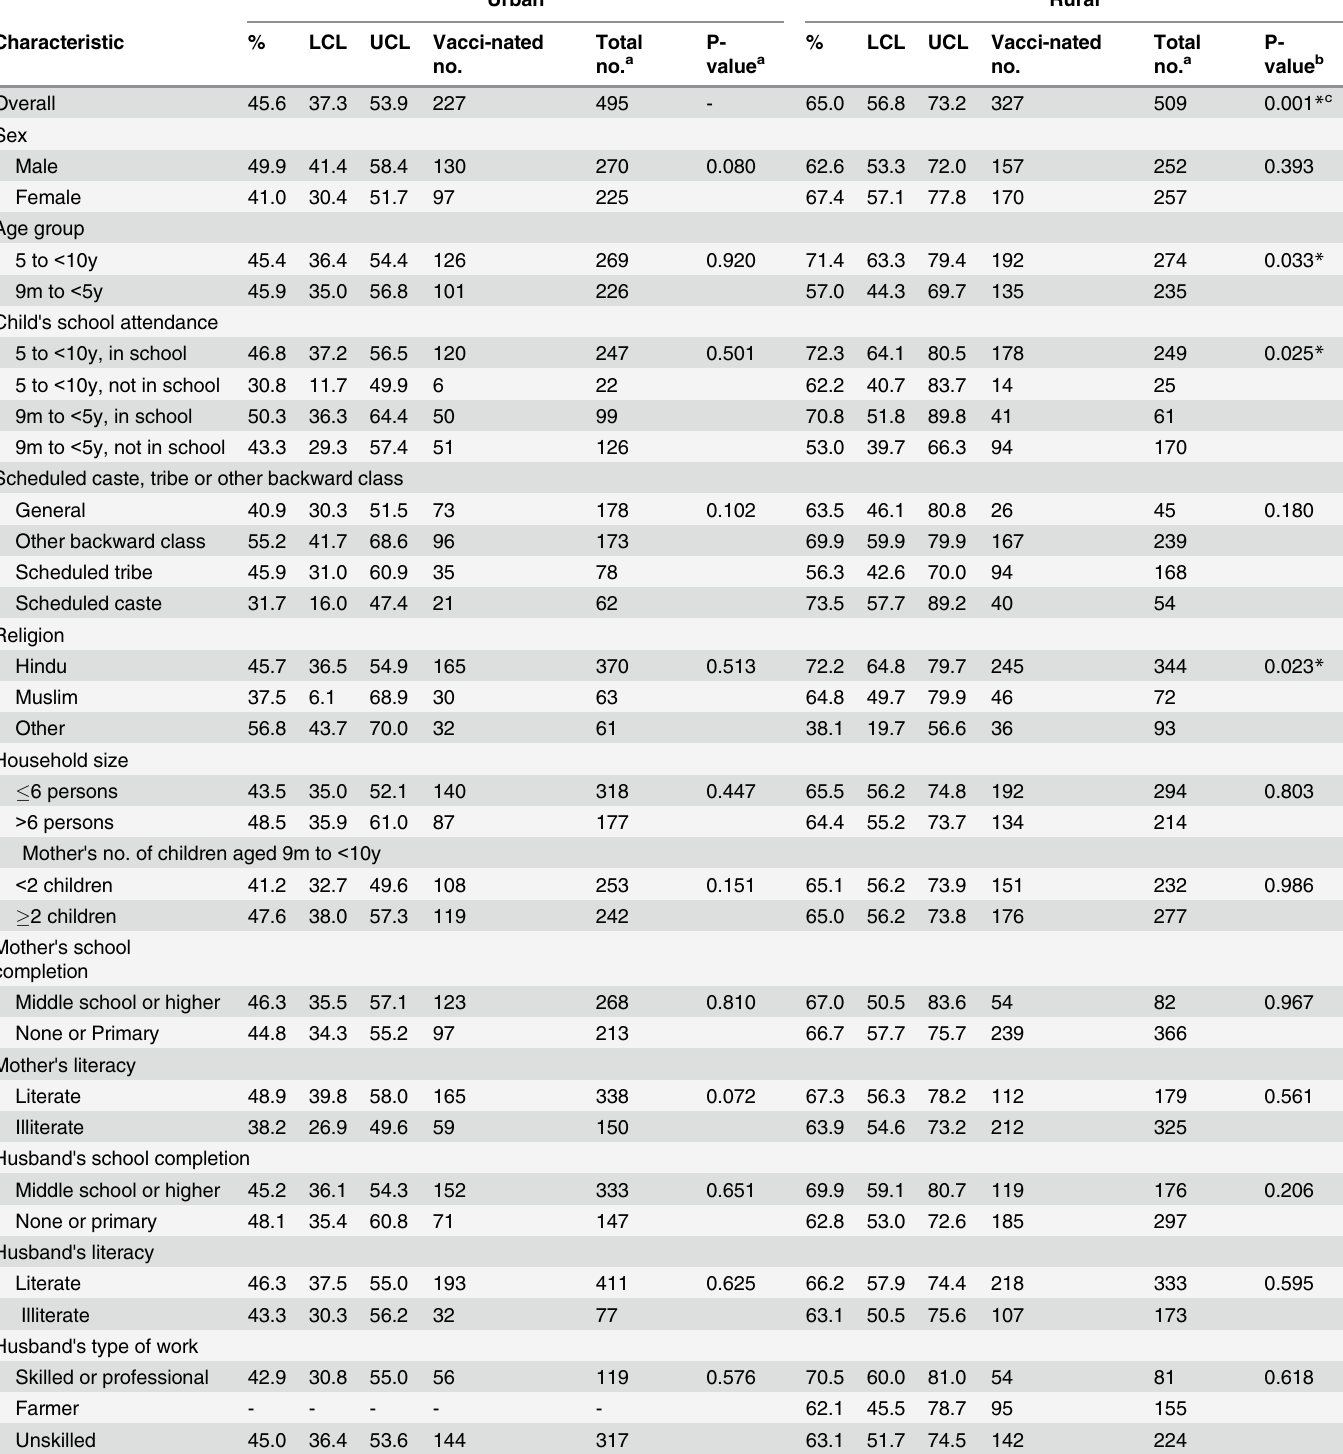
Table 3. Phase 2 measles vaccination campaign coverage estimates by socio-demographic characteristic for urban and rural areas, Jharkhand, 2012.